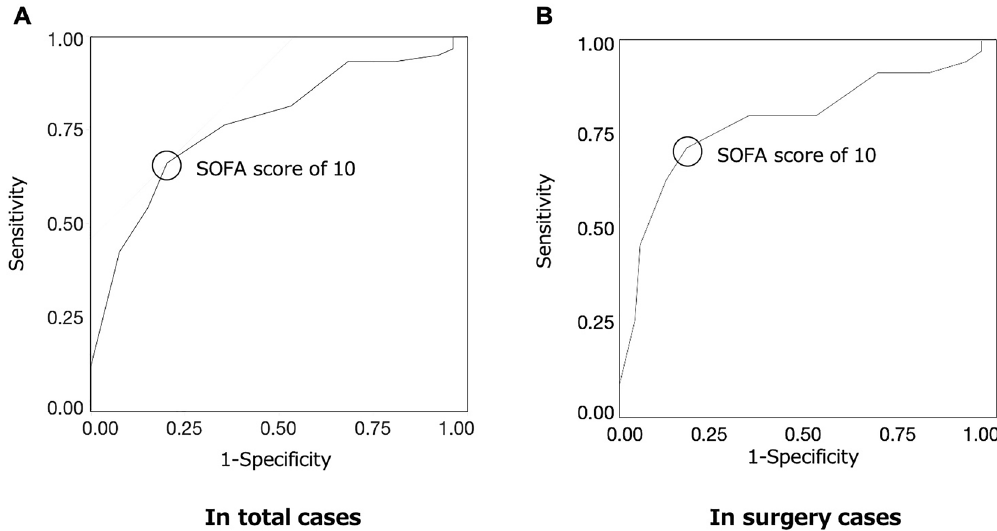
Figure 4. Receiver operating characteristic curve analysis for sedation period ( A ) in overall and ( B ) in surgery cases. Positive was defined as a sedation period of more than 3 days. The cutoff point of SOFA score was 10 in both: sensitivity, 0.66; specificity, 0.80; area under the curve, 0.77; standard error, 0.05 in overall and sensitivity, 0.71; specificity, 0.82; area under the curve, 0.79; standard error, 0.05 in surgery